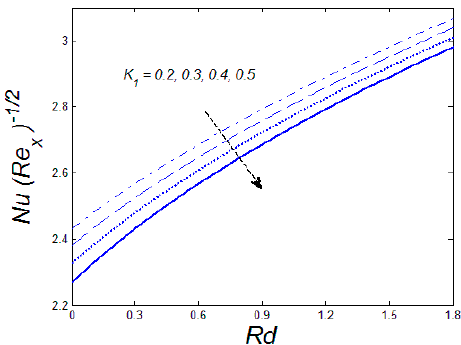
Figure 16. Upshot of K 1 and R d on Nusselt number NuRe − 1/2 x .